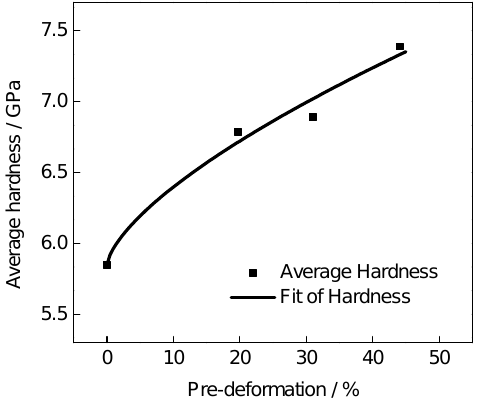
Figure 7. The fitted relationship between the hardness and pre-deformation of pre-deformed